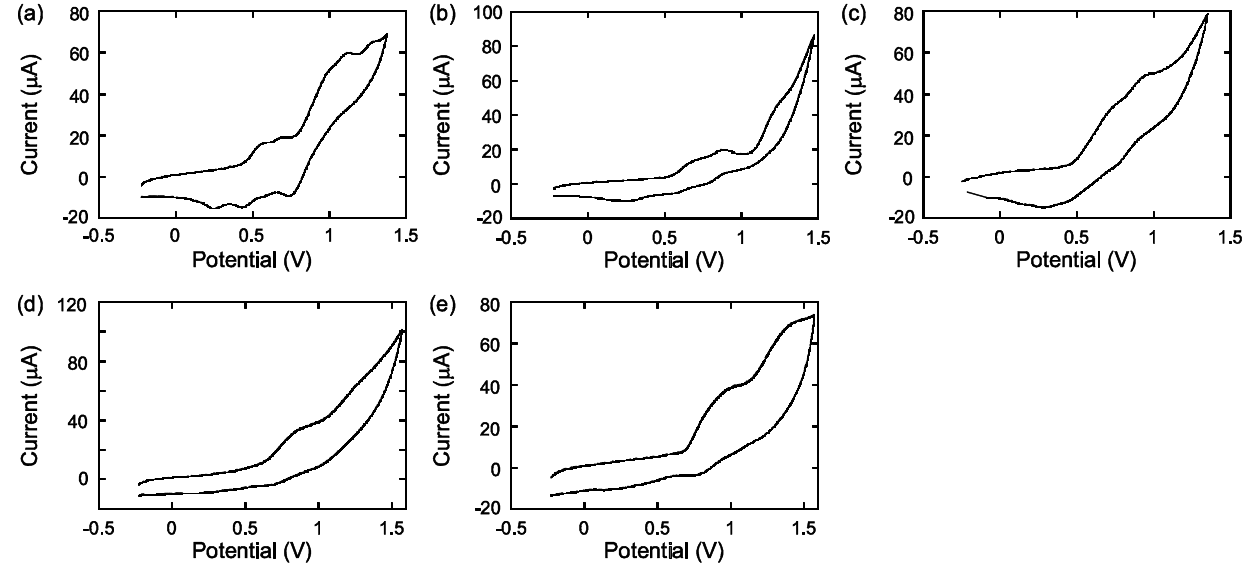
Figure 4. Cyclic voltammograms of (a) P1 , (b) P2 , (c) P3 , (d) P4 , and (e) P5 in CH with 0.1 M ( n C Potentials vs. Fc/Fc + couple.